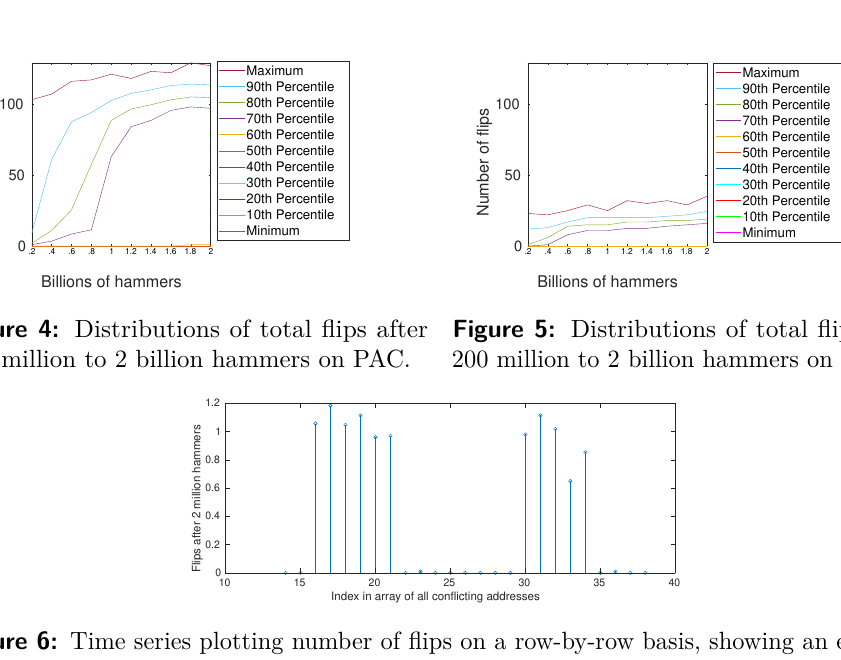
Figure 6: Time series plotting number of flips on a row-by-row basis, showing an example of the consistent placement of small-valued outliers (samples 23 and 36 on this graph) relative to their much larger neighbors. These rows only ever incur a few flips, compared to most “flippy” rows which incur dozens of flips, and always are located two rows away from a block of rows that flip much